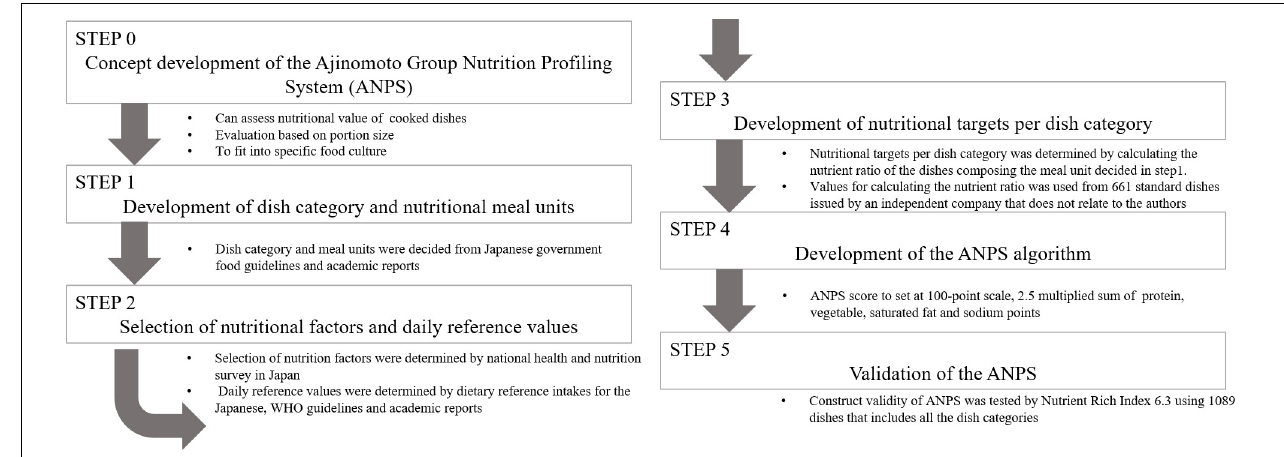
FIGURE 1 | Study approach for the development of the Ajinomoto Group Nutrient Profiling System (ANPS).